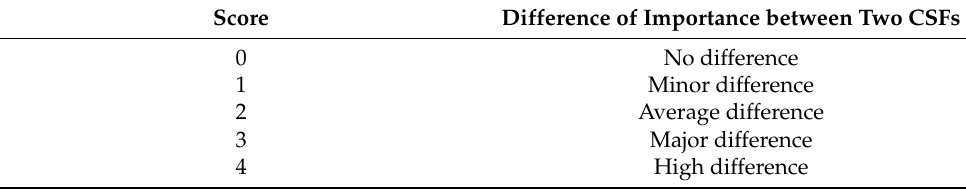
Table 4. Pairwise comparison scale for FCM. Score Difference of Importance between Two